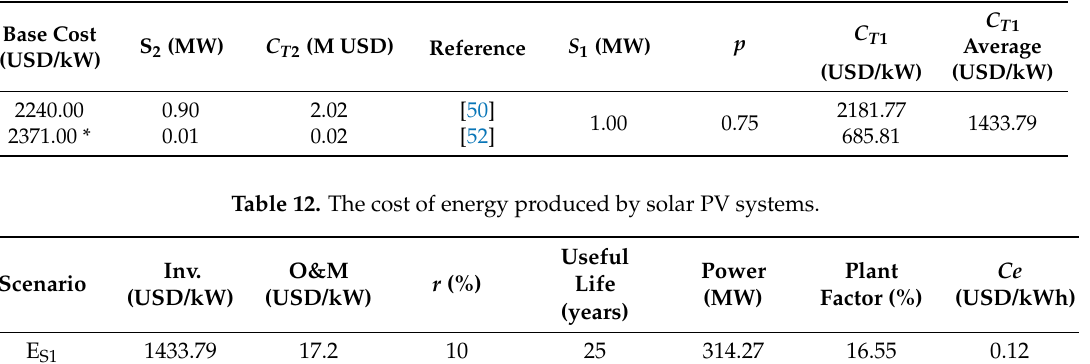
Table 11. The investment in photovoltaic (PV) systems.